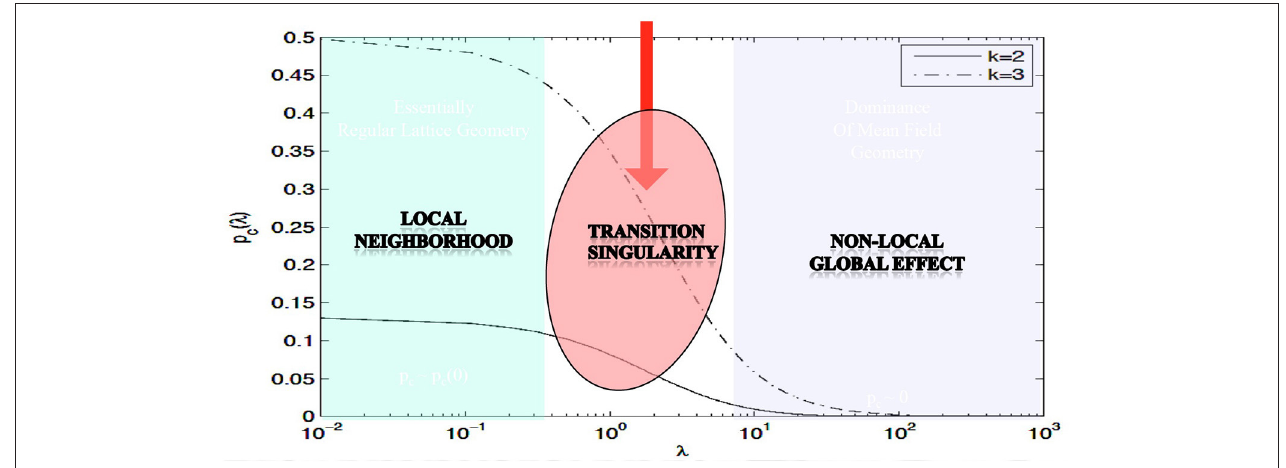
FIGURE 1 | Illustration of the effect of the long edges λ on the critical probability p c ; parameter k specifies the type of the update rule; based on Janson et al. (2019).